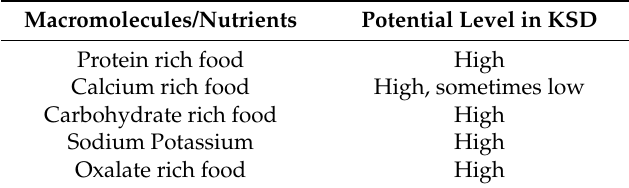
Table 3. Various macromolecules/nutrients and their effect on the level of